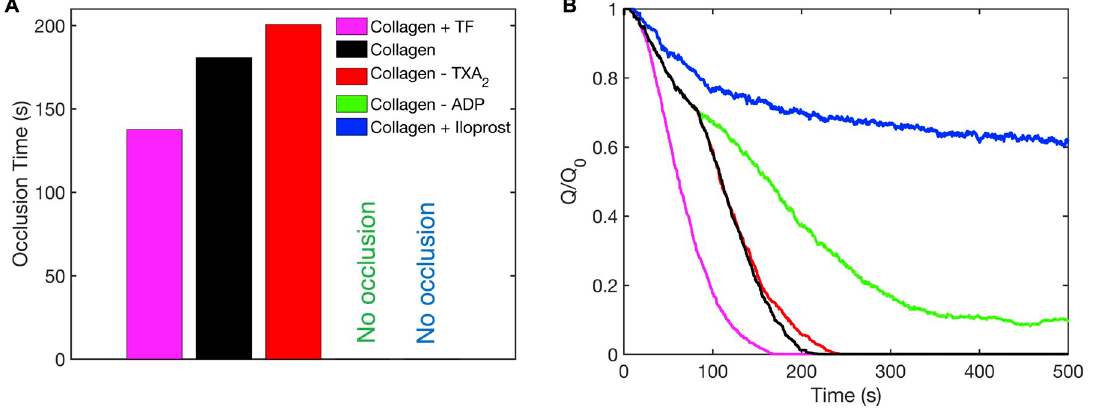
Fig 9. Platelet aggregation in a stenosis under agonist inhibition. (A) Observed occlusion times and (B) inlet volumetric flow rates (Q) versus time for different agonist conditions. The initial inlet flow rate (Q 0 ) was set to 1.3 μ L/min, giving an initial inlet wall shear rate of 1000s -1